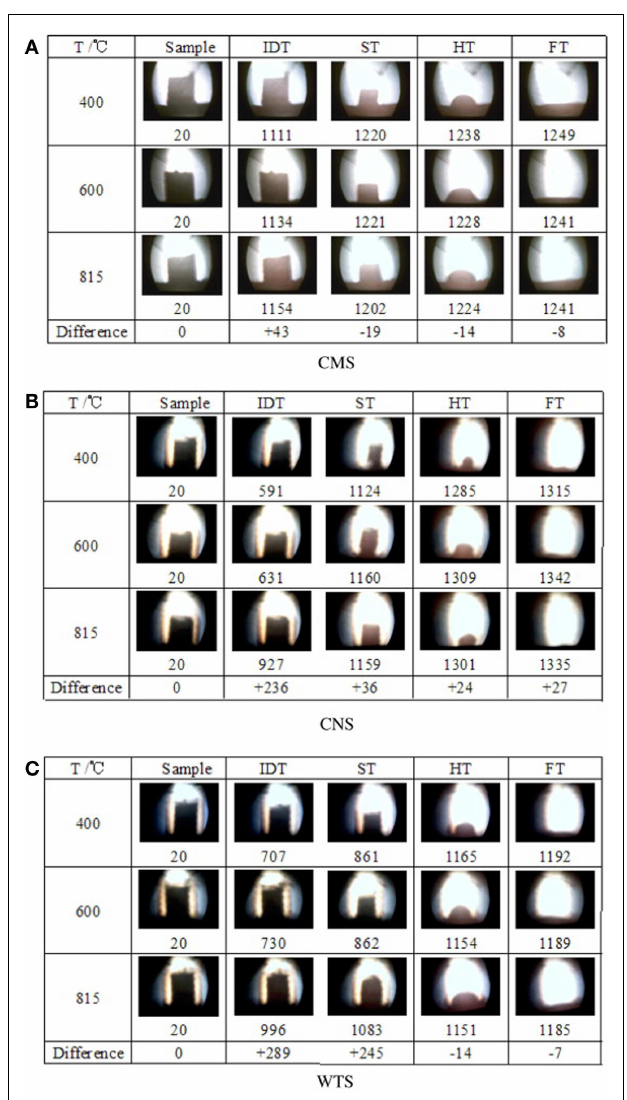
FIGURE 3 |Ash fusion temperatures of CMS (A), CNS (B), andWTS